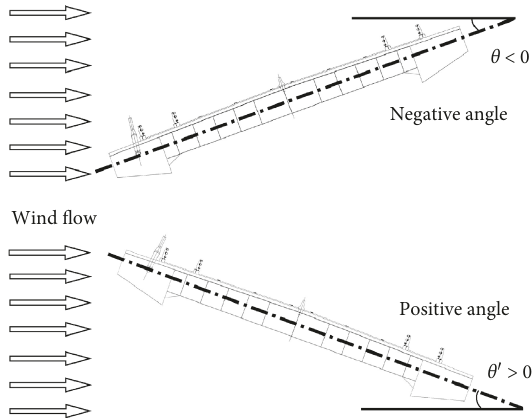
Figure 13: The effect of wind flow for the girder having large absolute value of AOA.